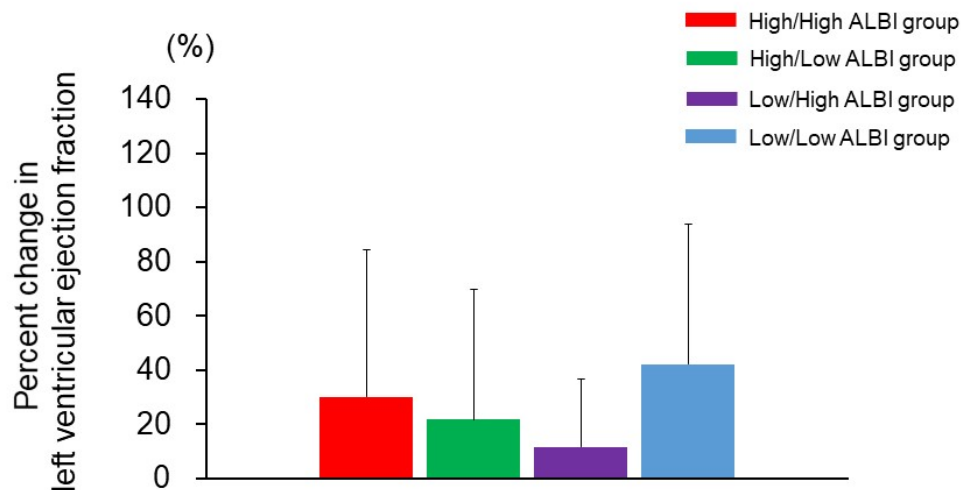
Figure 2. The percentage change in left ventricular ejection fraction from baseline to 6 months after cardiac resynchronization therapy among the four groups.